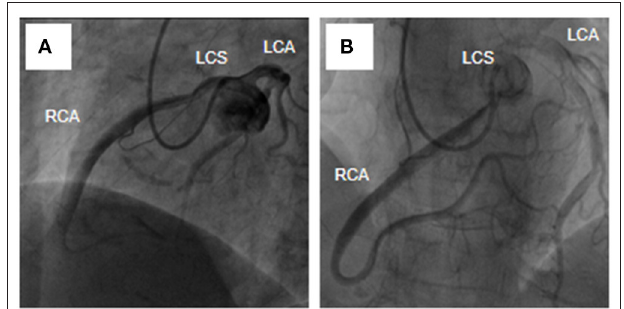
FIGURE 1 | Transradia coronary angiography showed AAORCA (A,B) . AAORCA, the anomalous aortic origin of the right coronary artery; RCA, right coronary artery; LCS, left coronary sinus; LCA, left coronary artery.